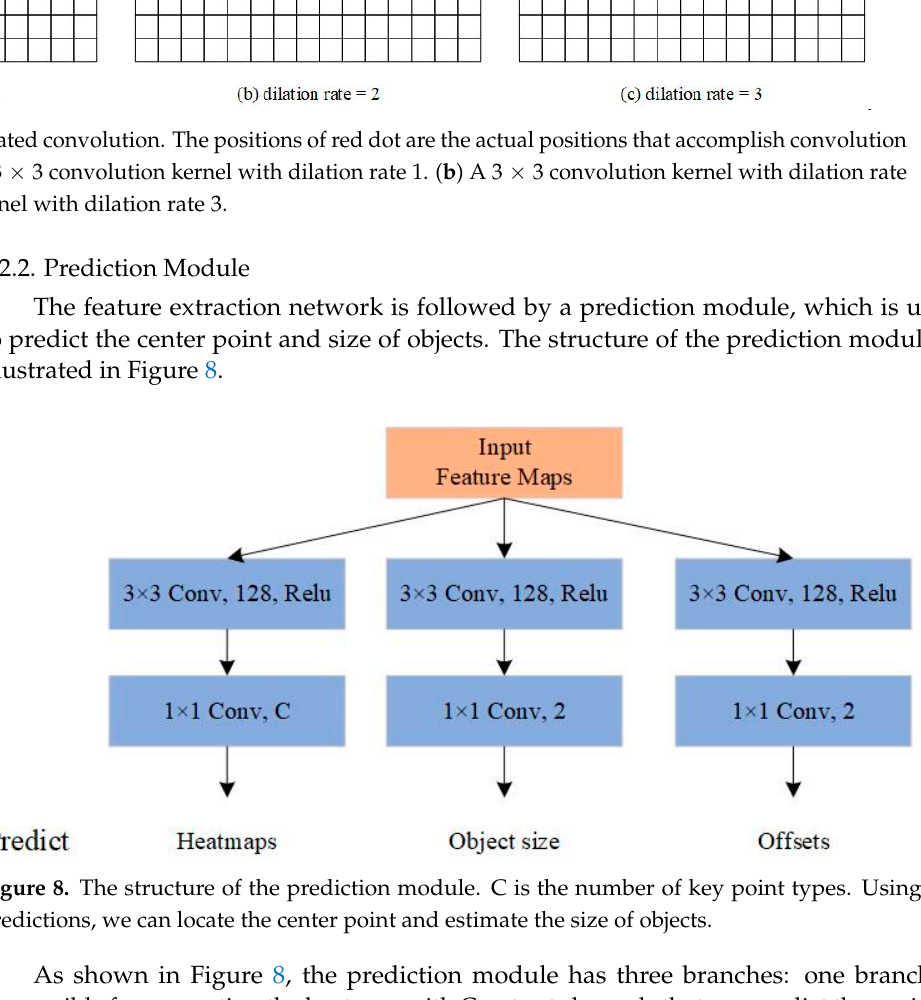
Figure 8. The structure of the prediction module. C is the number of key point types. Using the predictions, we can locate the center point and estimate the size of objects.